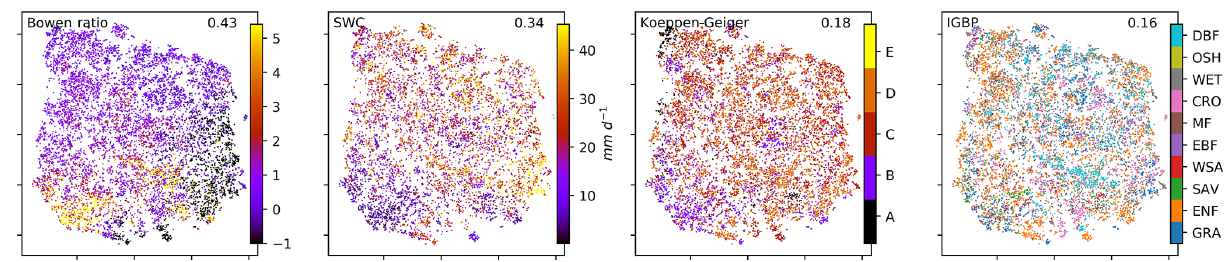
Figure B6. t -SNE space coloured by the underlying mean Bowen ratio and precipitation, as well as the ecosystem’s respective Köppen– Geiger class and IGBP